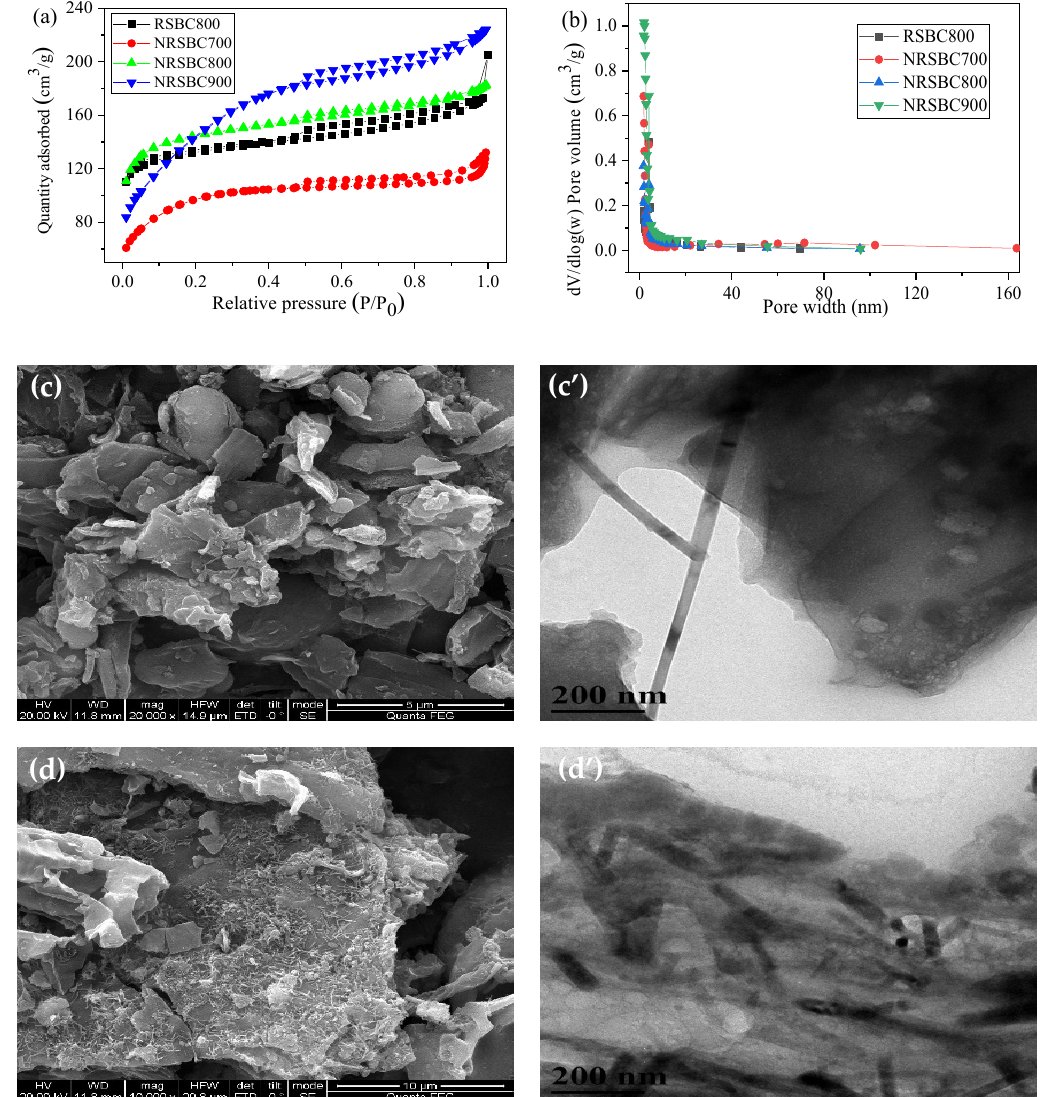
Figure 1. N 2 sorption isotherms ( a ) and pore size distributions ( b ) of different materials (RSBC800, NRSBC700, NRSBC800 and NRSBC900); SEM and TEM images of RSBC800 ( c , c’ ) and NRSBC800 ( d , d’ ).